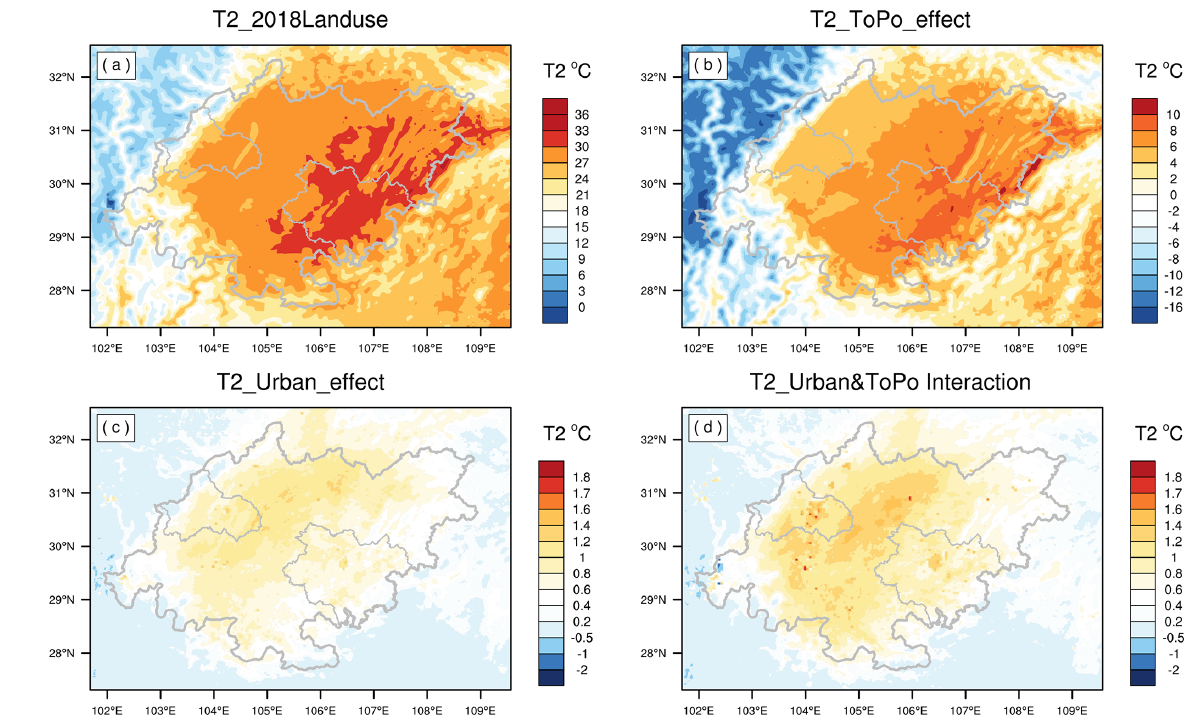
Figure 6. Effects of urbanization on 2m temperature: (a) 2m average temperature distribution with 2018 land use; (b) topography effect; (c) urban effect; (d) urban–topography